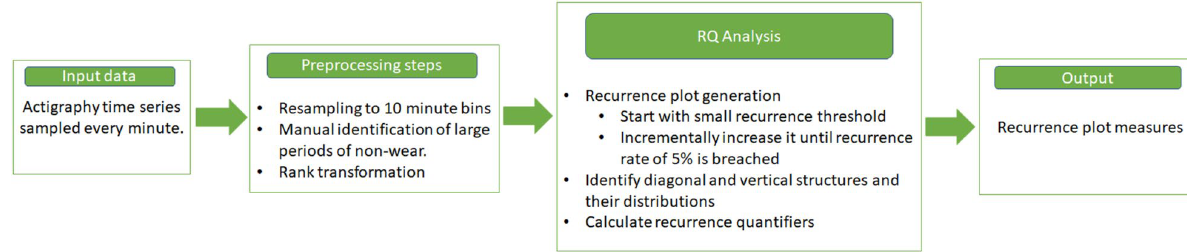
Figure 2. Flowchart indicating the analysis procedure, described in this paper, to extract recurrence plot measures from actigraphy points that form diagonal structures to the ratio of all recurring points. Thereby, it provides an estimate of how often different parts of a time series co-evolve as a fraction of the total number of data point pairs in the plot. For a purely noisy process, with no underlying dynamics, this measure is very small, whereas for a process with underlying deterministic dynamics, the DET measure is high. Similarly, the laminarity or LAM measure reflects frequent periods of rest or physical activity that results in constant activity counts for an extended duration will lead to a higher LAM measure as opposed to cases when such patterns are rare. A further useful quantifier in this context is the ratio of the LAM to DET measure, which quantifies how often vertical structures appear in the system as a fraction of diagonal structures 45 . While all the quantifiers mentioned above relate to the complexity of patterns found in the recurrence plot, the mean and entropy of the distributions relate directly to the duration of recurrent activity patterns and the diversity of such patterns. A summary of the recurrence-based quantifiers used in this paper is given in Table 1. To illustrate the difference between time series data that is dominated by noise processes and one which is dominated by a periodic signal, we contaminated a sine wave by adding varying levels of white noise to them. The level of noise contamination is measured as the ratio of the mean squared expectation of the signal to noise (signal to noise ratio or SNR). Sample recurrence plots from these noise contaminated sine waves (SNR 5 and 1), along with a pure sine wave and a pure white noise signal, are shown in Fig. 3. The simulation of sine waves rence plot becomes more diffused.